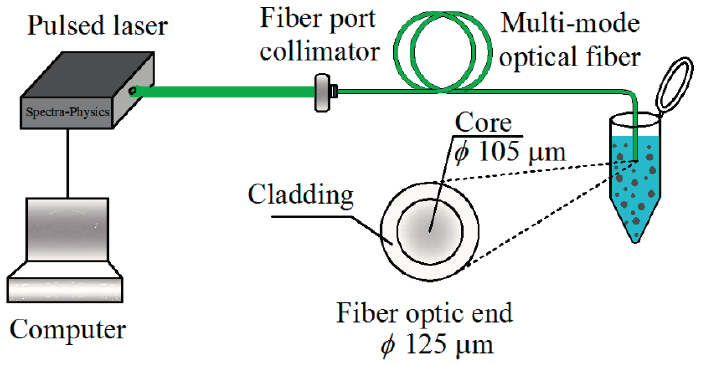
Figure 1. Experimental setup for photodepositing silver nanoparticles on the optical fiber end.